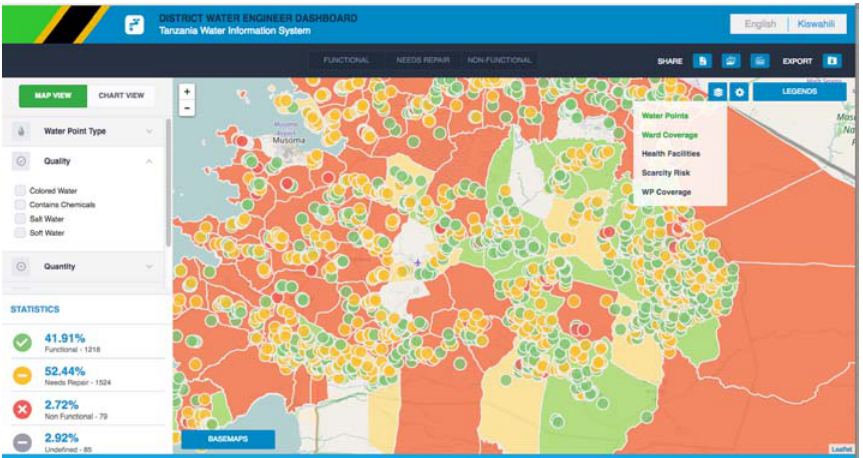
Figure 3. DWE dashboard that make use of the SEMA infrastructure to present data dynamically.